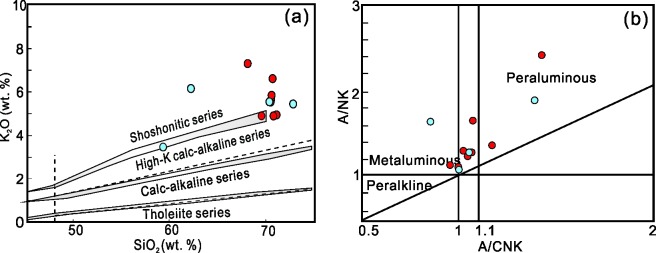
Plots of (a) SiO2 versus K2O (after Le Maitre et al., 1989, Rickwood et al., 1989); (b) A/NK versus A/CNK; A/NK = Al2O3/(Na2O + K2O), A/CNK = Al2O3/(CaO + Na2O + K2O), molecular ratio; (after [48]). Symbols are same as Fig 6.